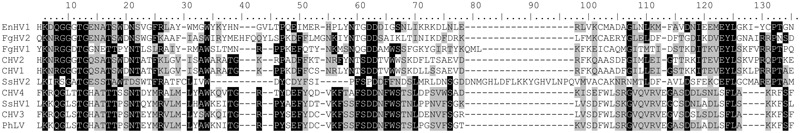
Alignment of the homologous regions corresponding to the putative RNA-dependent RNA polymerase site (superfamily cd01699) in several hypoviruses. Virus abbreviations as in Figure 3.